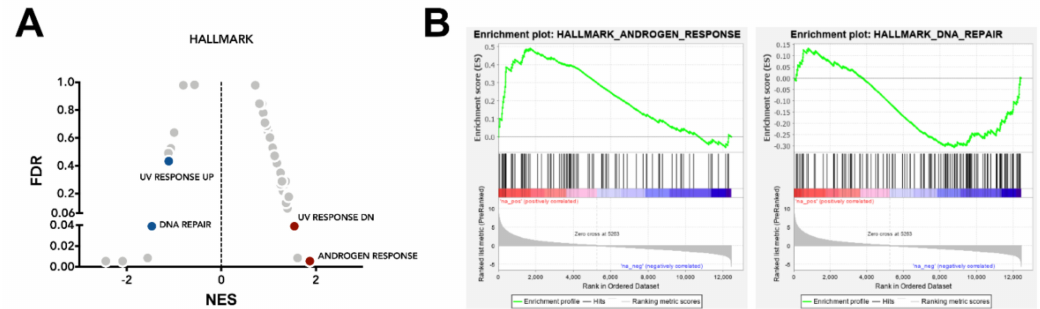
Figure3. F133VSPOPmutationderegulatesDNArepair-relatedpathways. ( A )VolcanoplotofHallmark collection gene sets from Molecular Signature database (MsigDB); normalized enrichment score (NES) and false discovery rate (FDR, 0.05 threshold to assess significance) were plotted. Dots highlight the enriched gene sets in F133V SPOP mutated (red) and in WT (blue) cells. ( B ) Gene set enrichment analysis (GSEA) enrichment plot of “androgen response” and “DNA repair” in the comparison between F133V SPOP and WT DU145